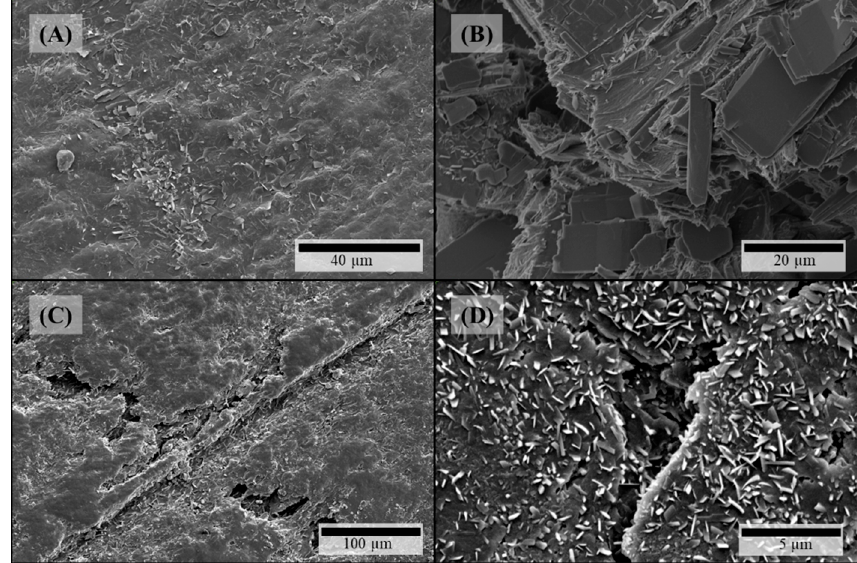
Figure 2. SEM pictures of HPMC-based filaments: ( A ) HPMC15 surface; ( B ) HPMC15 fracture face; ( C ) HPMC50 surface; ( D ) HPMC50 fracture face.